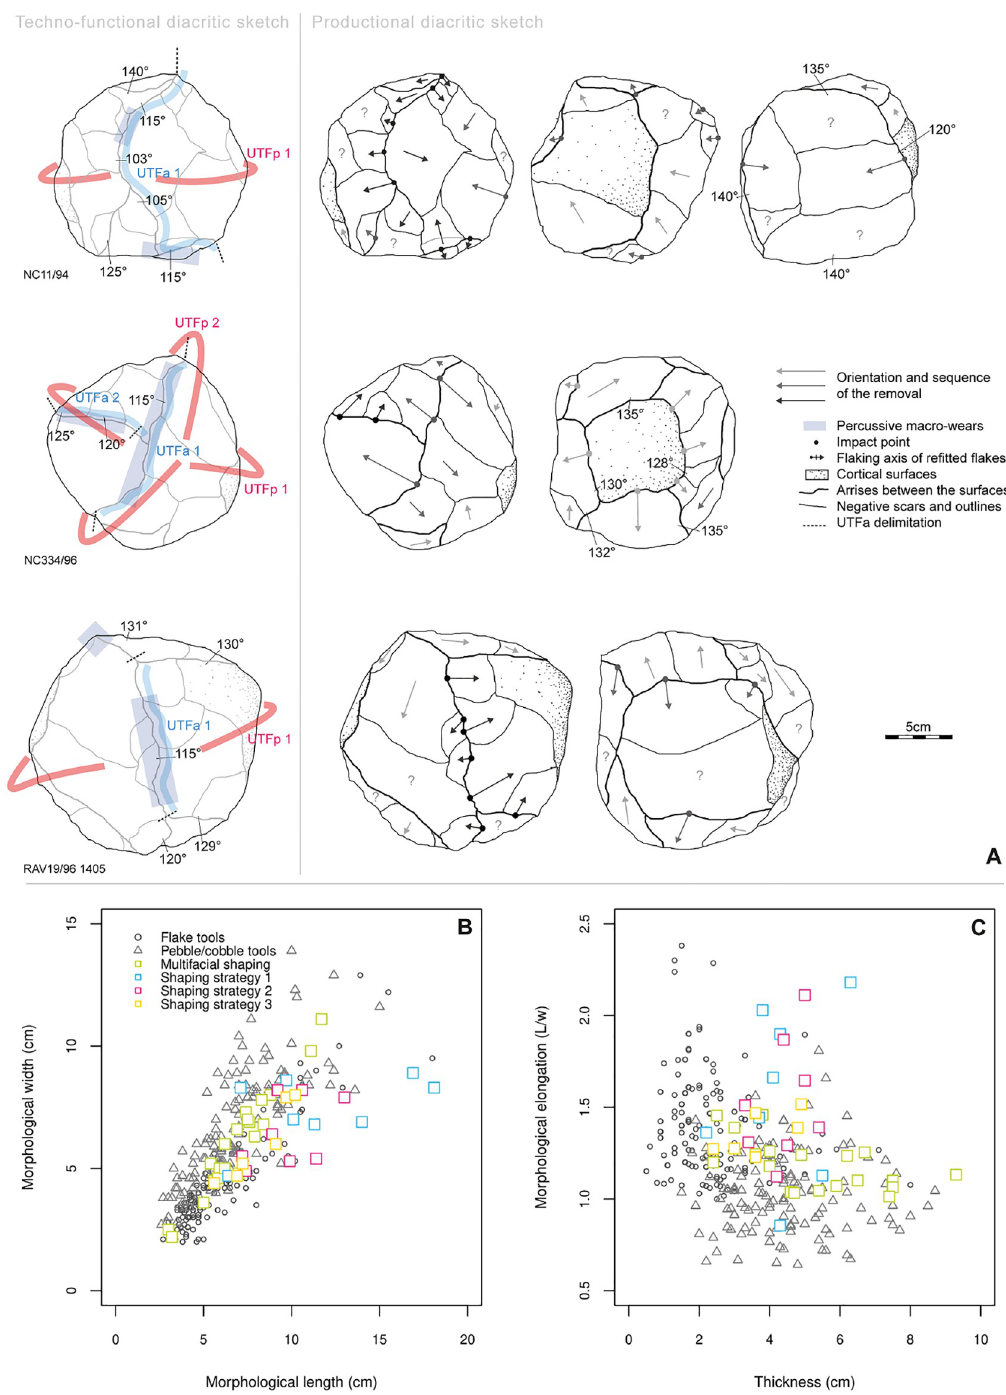
Fig 12. A: examples of polyhedra from Dungo IV showing the consistency between the production and techno-functional approaches. B and C are biplots of morphological length, width, thickness and elongation (Length/width) of the different tool